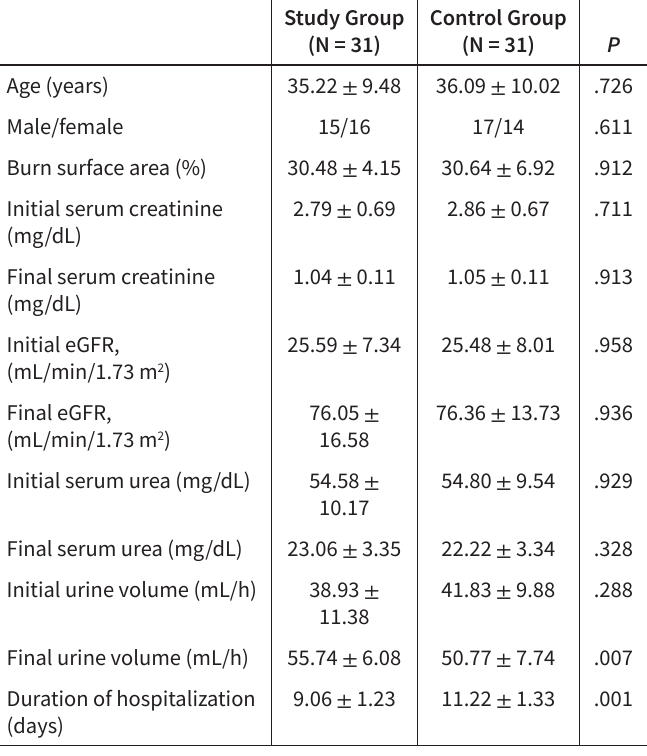
Table 1. Patients’ Demographic and Laboratory Data in the Beginning and at the End of the